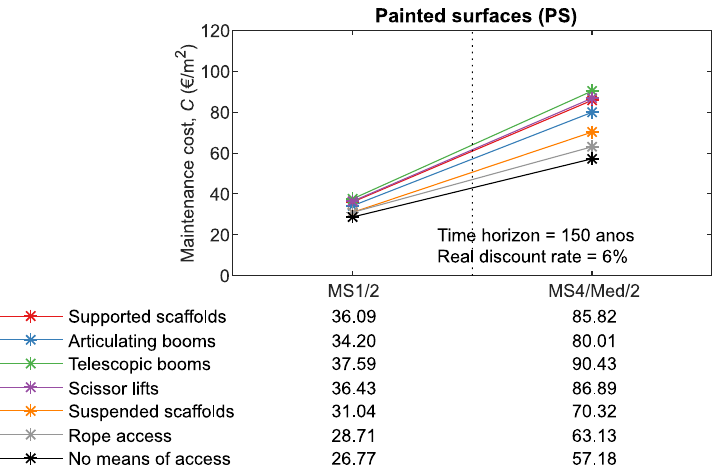
Figure 5. Sensitivity analysis of the different means of access in PS maintenance strategy costs for a time horizon of 150 years.